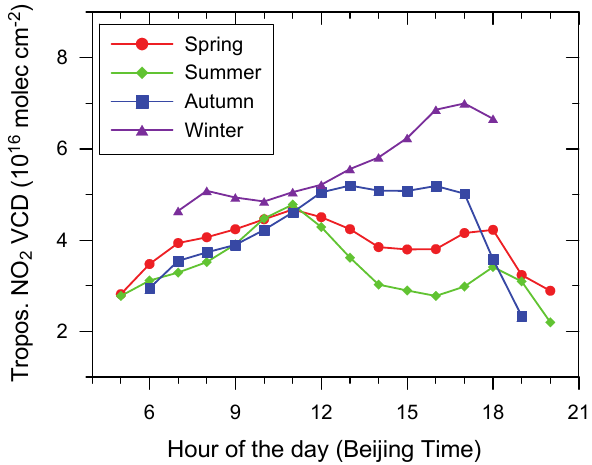
Fig. 7. Diurnal variations of the tropospheric NO 2 VCD, averaged for different seasons from August 2008 to September 2011.